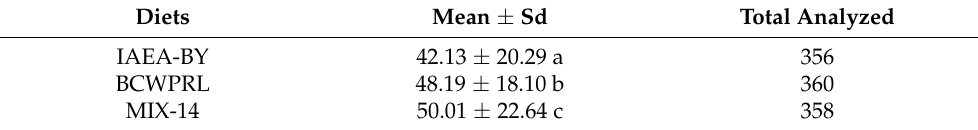
Figure 3. The survival curves of males fed in the larval stage with IAEA-BY, BCWPRL, and MIX-14 diets (all the presented data are complete; there are no censored data). Table 4. The mean survival time of Aedes albopictus males that were fed different diets as larvae.